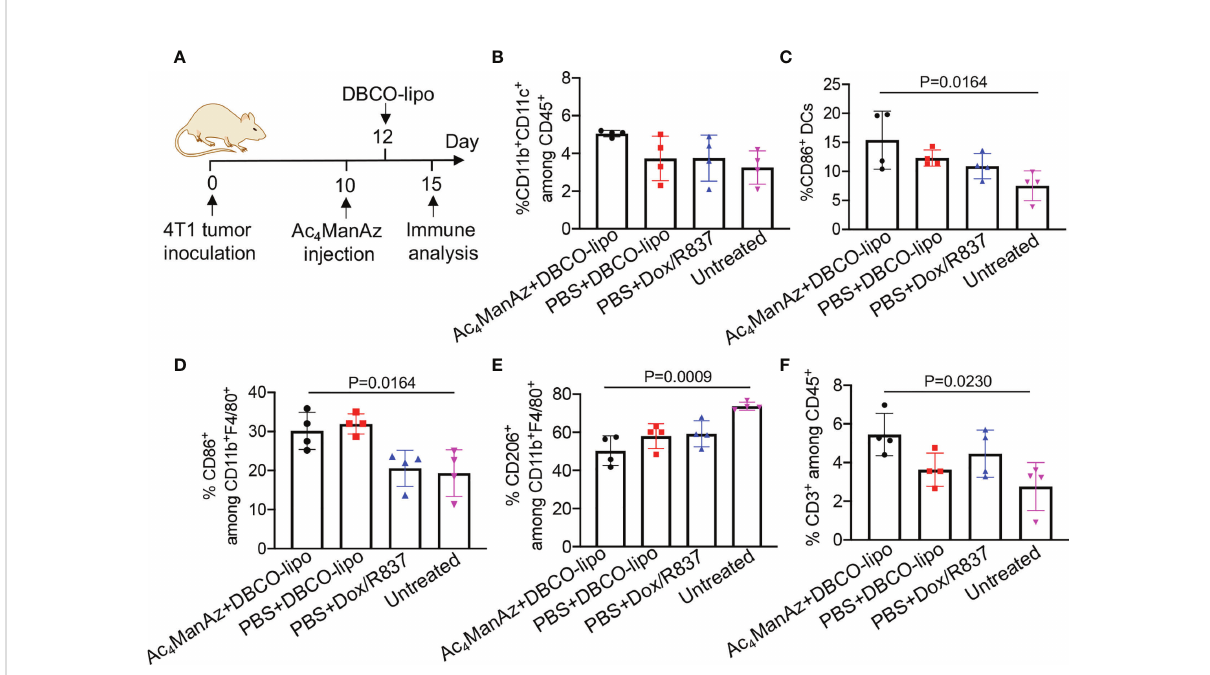
FIGURE 7 Azido sugar coupled with Dox/R837-loaded DBCO-liposomes alters the immunosuppressive tumor microenvironment. (A – F) 4T1 tumors were inoculated on day 0, followed by intratumoral injection of Ac 4 ManNAz (or PBS) on day 10 and DBCO-liposomes (or a mixture of Dox and R837) on day 12. On day 15, tumors were collected for immune analysis. (A) Timeframe of tumor study. Shown are the percentages of (B) CD11b + CD11c + DCs among CD45 + immune cells, (C) CD86 + cells among CD11b + CD11c + DCs, (D) CD86 + cells among CD11b + F4/80 + macrophages, (E) CD206 + cells among CD11b + F4/80 + macrophages, and (F) CD3 + T cells among CD45 + immune cells in tumors after different treatments. All the numerical data are presented as mean ±